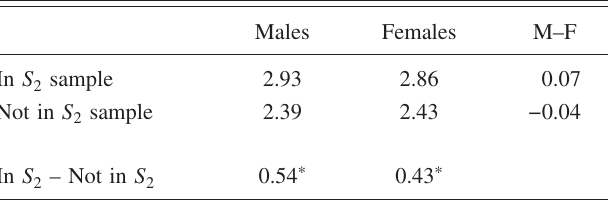
significant via F test at the p (cid:1) 0.01 level (cid:2) . The R 2 for the